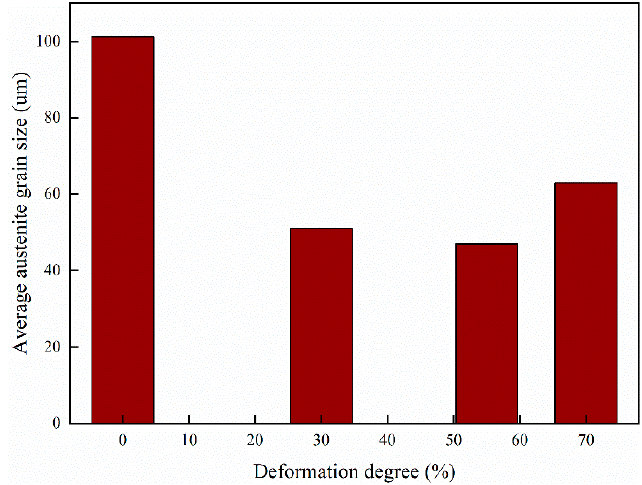
Figure 7. The average grain size of the retained austenite after different degrees of deformation.